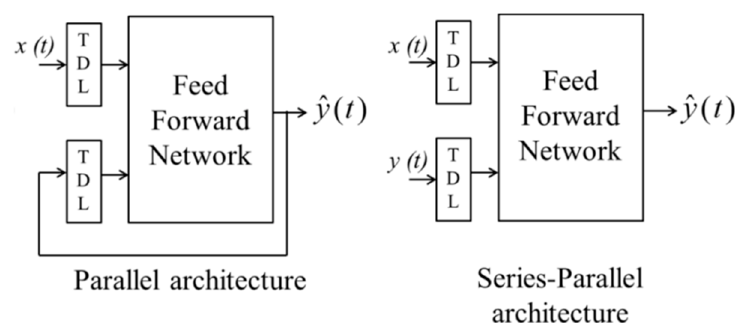
Figure 3. The two neural network architectures of nonlinear autoregressive network with exogenous inputs (NARX).